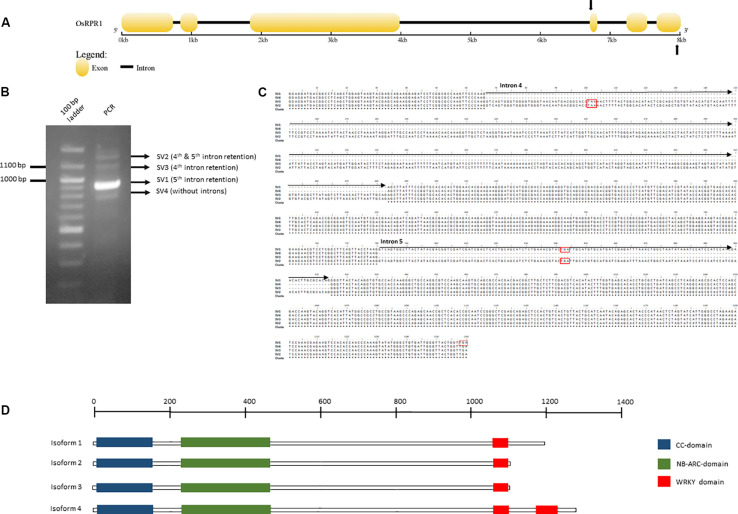
Organization of the OsRPR1 gene (A) and the PCR amplified splice variants produced after PCR amplification with primers spanning the fourth and sixth exon (B, C). The putative isoforms rising from this splice variants and their domains are depicted in (D). The complete DNA sequences of the putative splice variants and the corresponding isoforms are provided in Supplementary File 2.